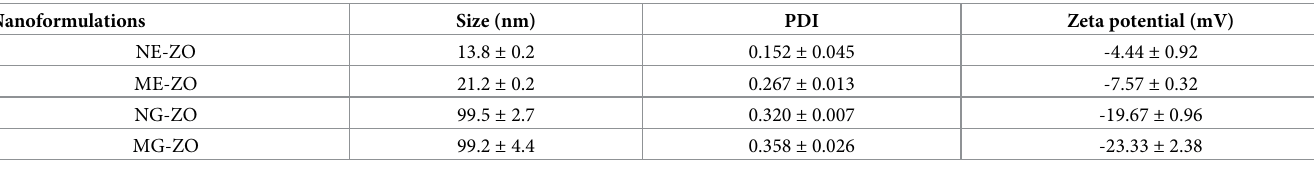
Data represent mean ± standard deviation